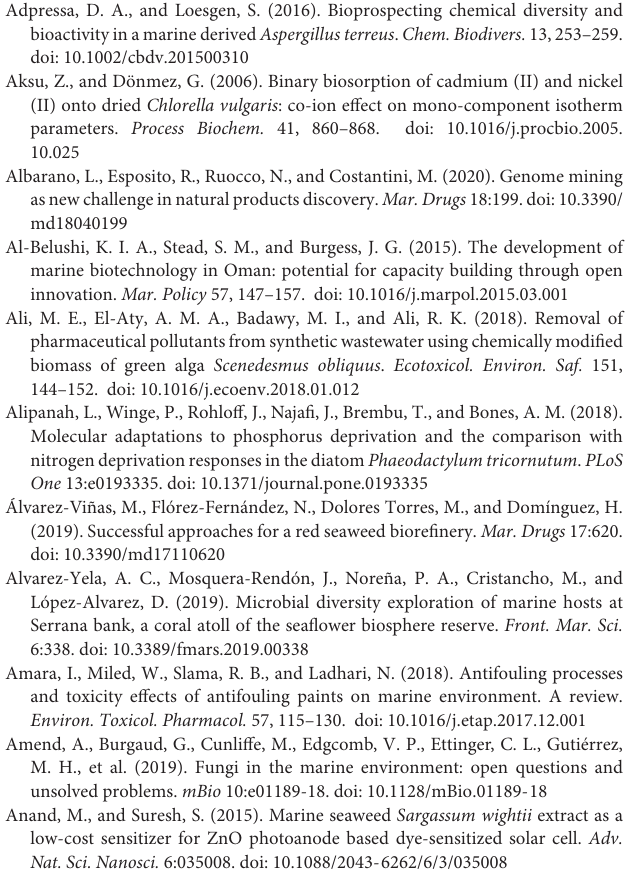
Supplementary Figure 1 | Identification of key compounds in Microcystis aeruginosa PCC 7806extracts. 1 – Aeruginosin 684; 2 – M + 2H 392 & MH + 783; 3 – Linear MC-LR; 4 – M + 2H 615; 5 – MC-LR & DMLR (20%); 6 – Cyanopeptolin A; 7 – Aerucyclamide D; 8 – Cyanopeptolin 963A (–H 2